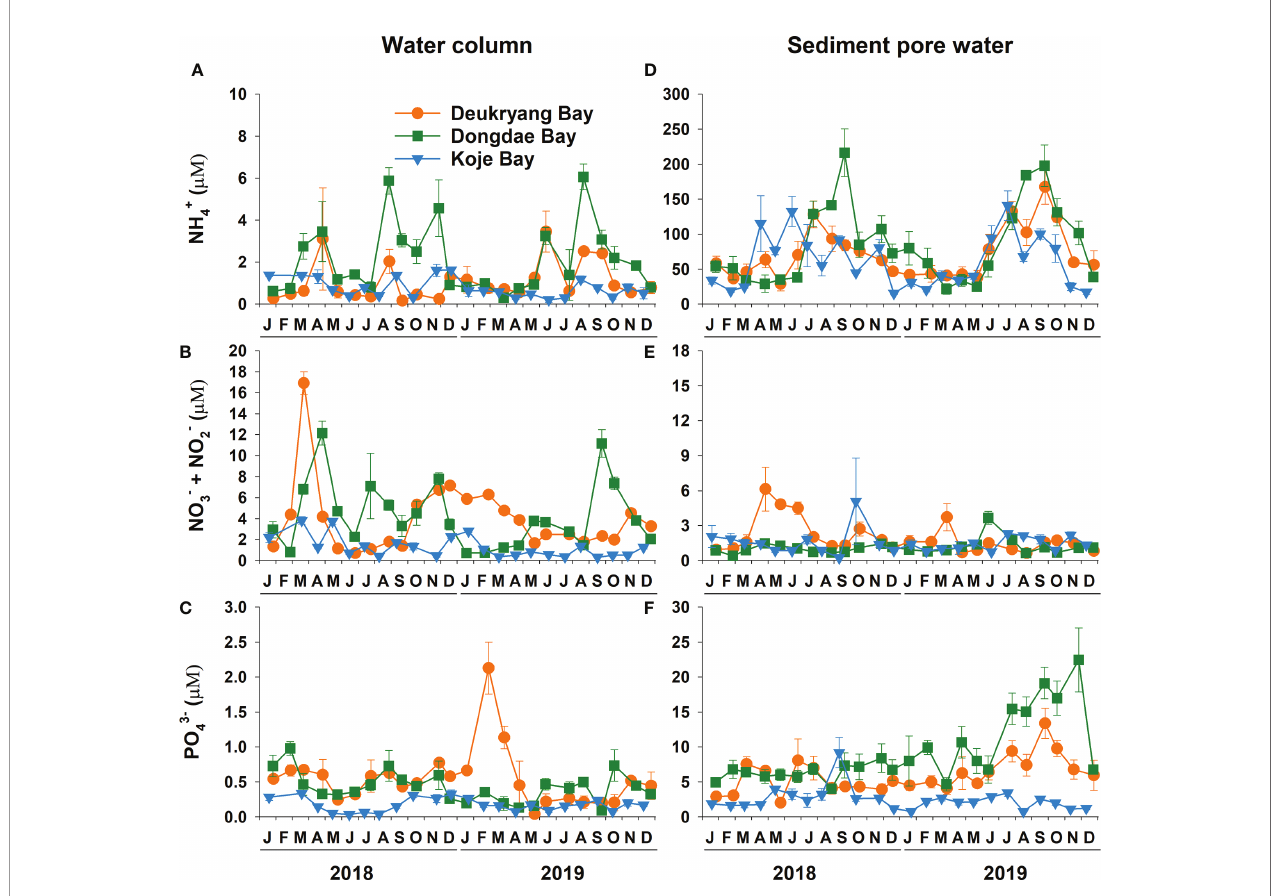
FIGURE 3 | Seasonal variations in NH + 4 , NO − 2 +NO − 3 , and PO 3 − 4 concentrations of the water column (A – C) and sediment pore water (D – F) in Deukryang Bay, Dongdae Bay, and Koje Bay on the southern coast of Korea from January 2018 to December 2019. Values are means ± SE (n = 3 –